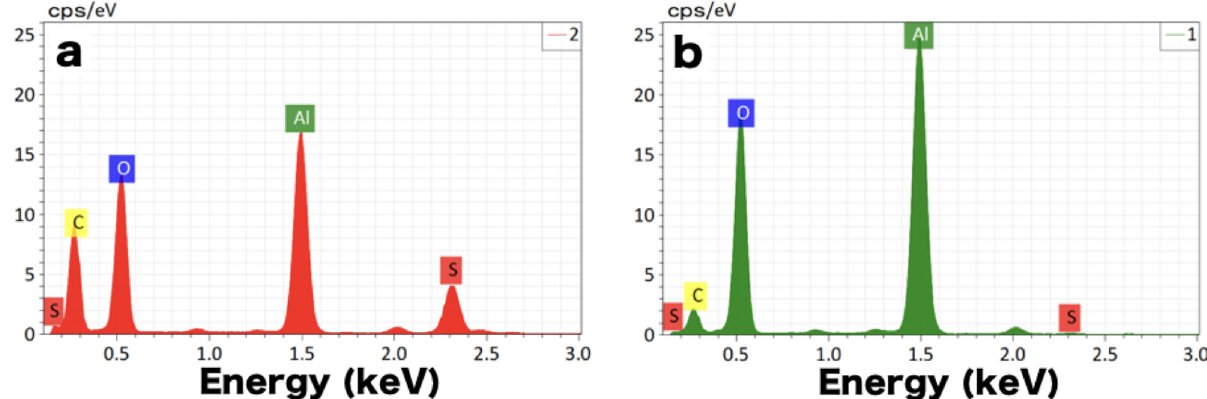
Fig. 5. EDX spectra acquired from the upper (a) and bottom (b) parts of the interfacial region of the joint with NMT2 surface treatment indicated as the regions in Figure 3a.